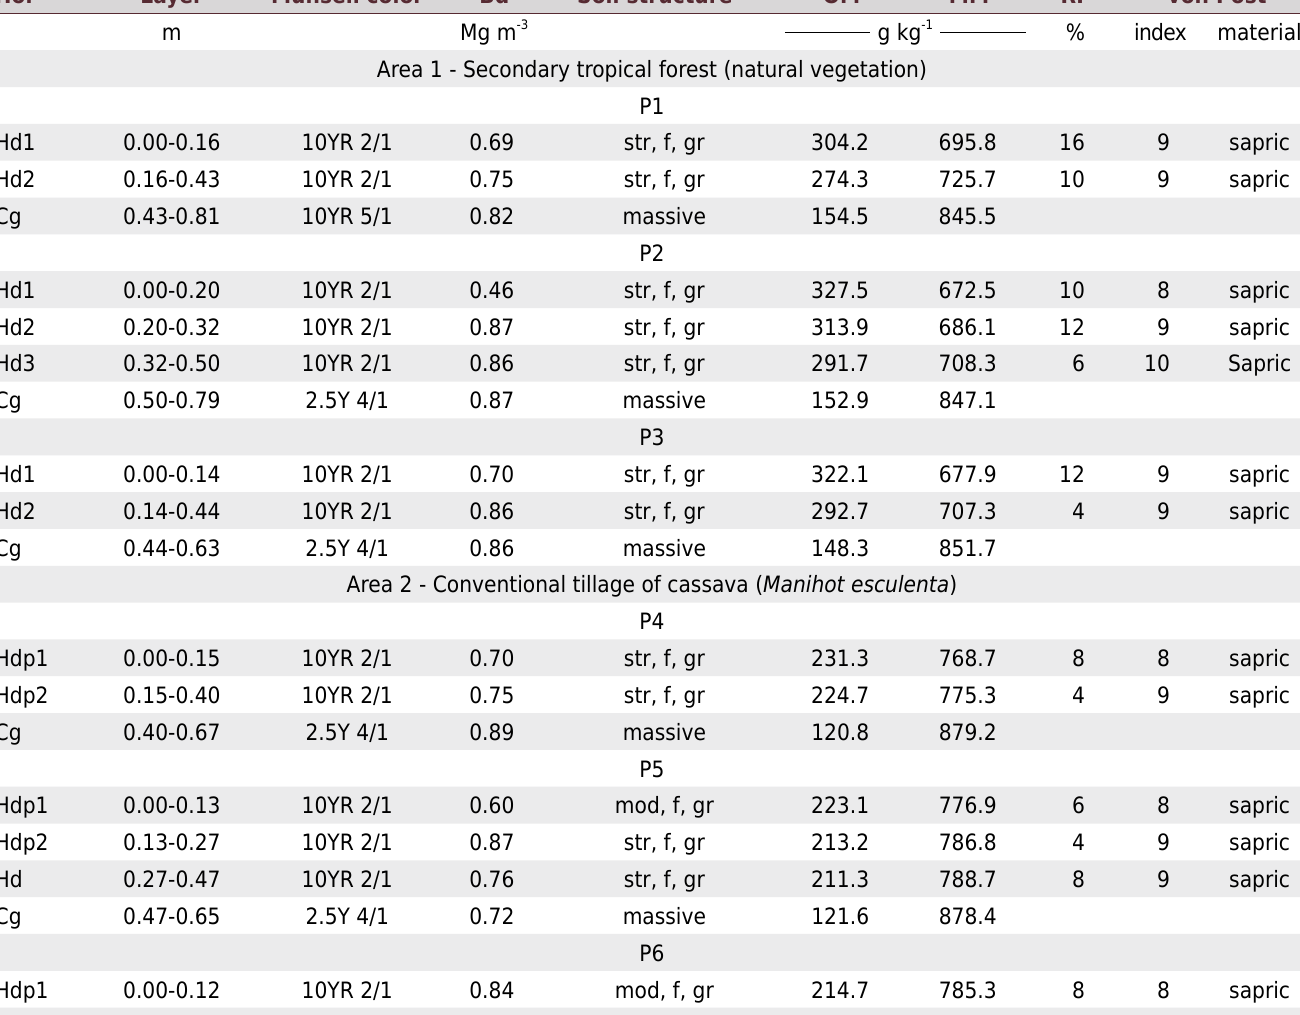
Table 2. Morphological properties description and selected features of the studied Histosol profiles Hor